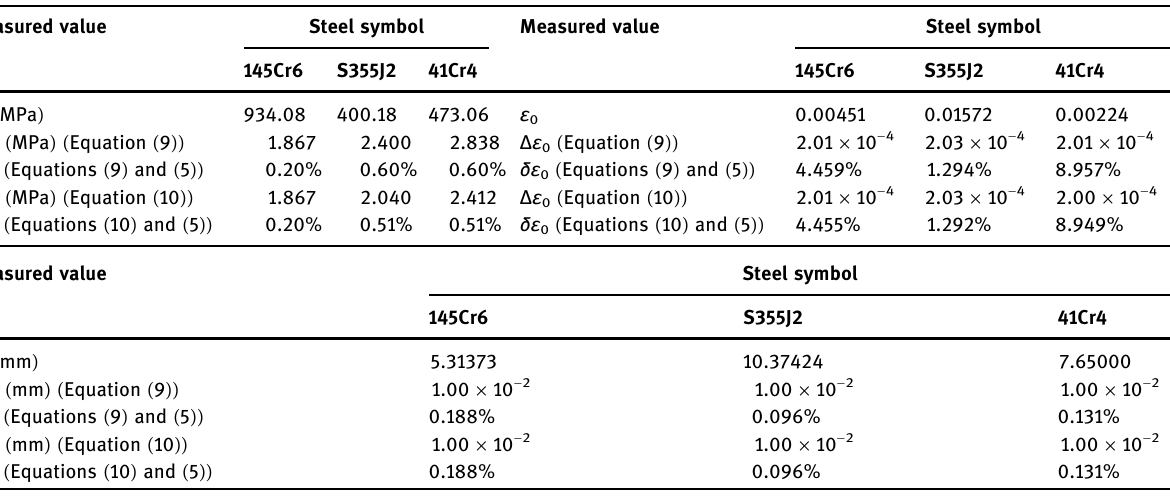
Table 3: Determined in accordance with the method presented in paragraph 3 and absolute and relative error values of selected quantities determined during a static tensile test ( selected results of the calculations )